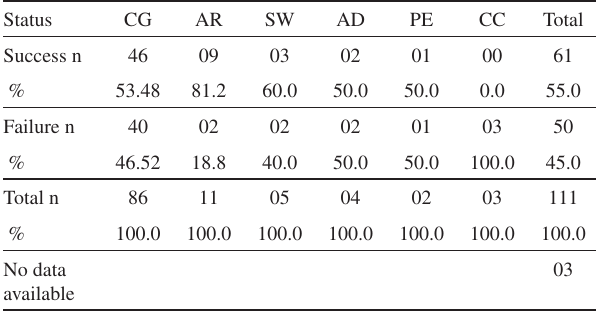
Table 4 - Success and failure correlated with